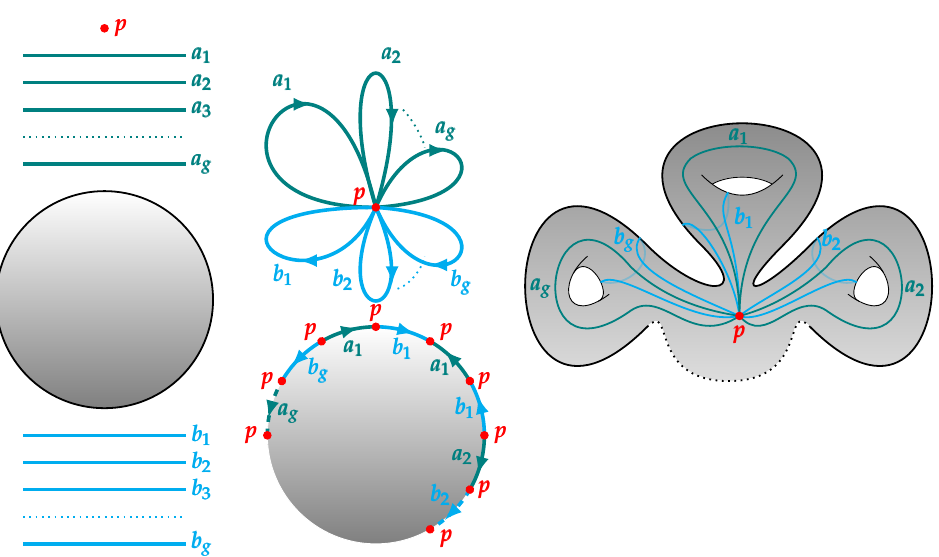
Figure 14. A cellular decomposition of a genus g surface. All the boundaries of the 2 g one dimensional cells are glued to a point, giving a one dimensional skeleton. Then the boundary of the two dimensional disc is glued to the skeleton, gluing the red points to p and the remaining parts to the corresponding lines (two segments for each curve) respecting the drawn orientations.